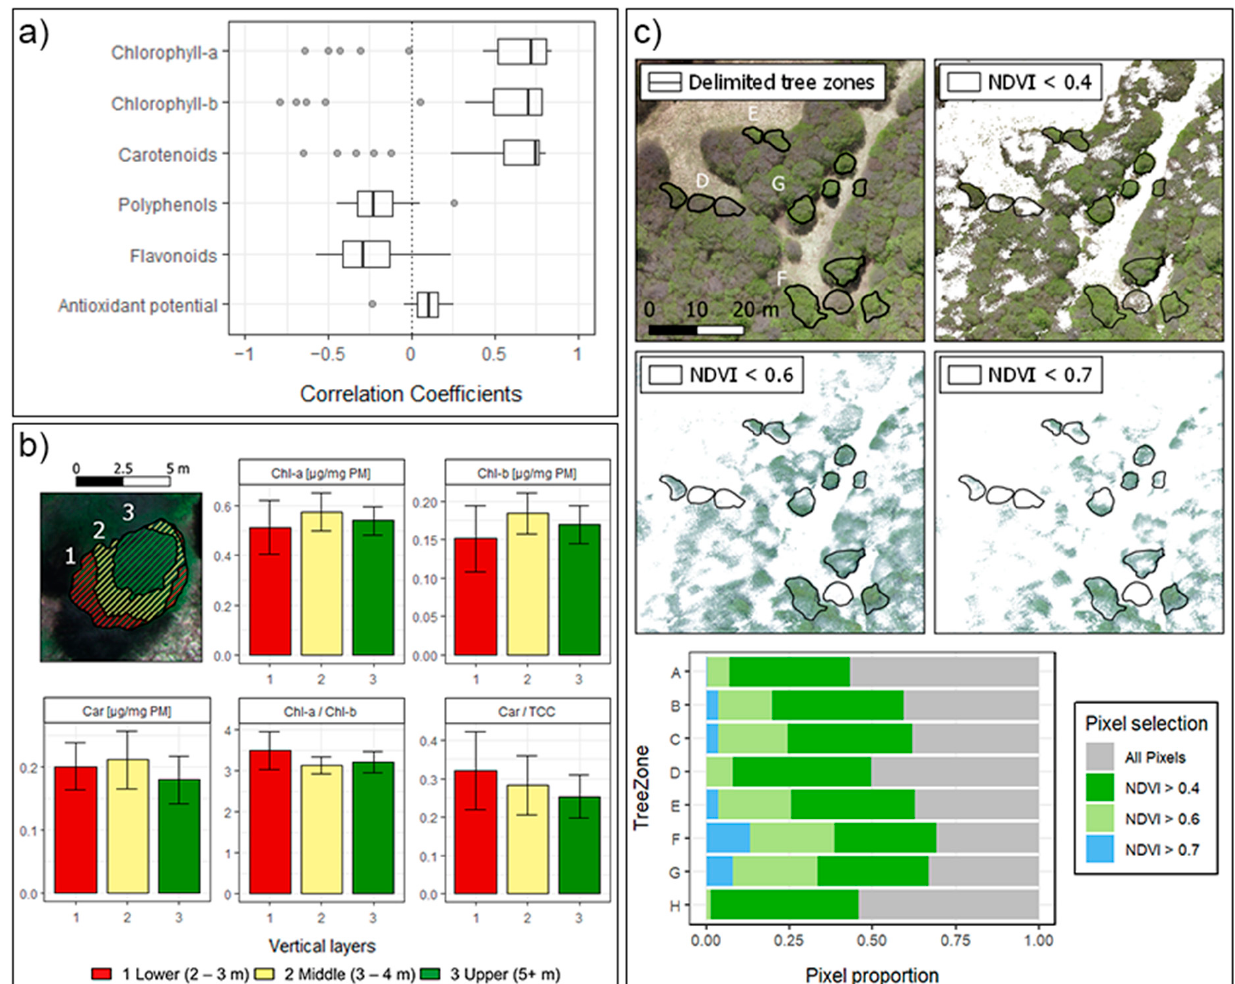
Figure 9. ( a ) Distribution of Correlation Coefficients for the biochemicals. ( b ) Vertical profile of a single Nothofagus pumilio tree from Zone G. Height was measured using RGB DSM, considering surrounding ground as 0 m. ( c ) Upper. Visualization of different NDVI criteria for the green pixels selection, zones D, E, F, and G are delimited. Lower. Distribution of pixels considering different NDVI criteria within each tree